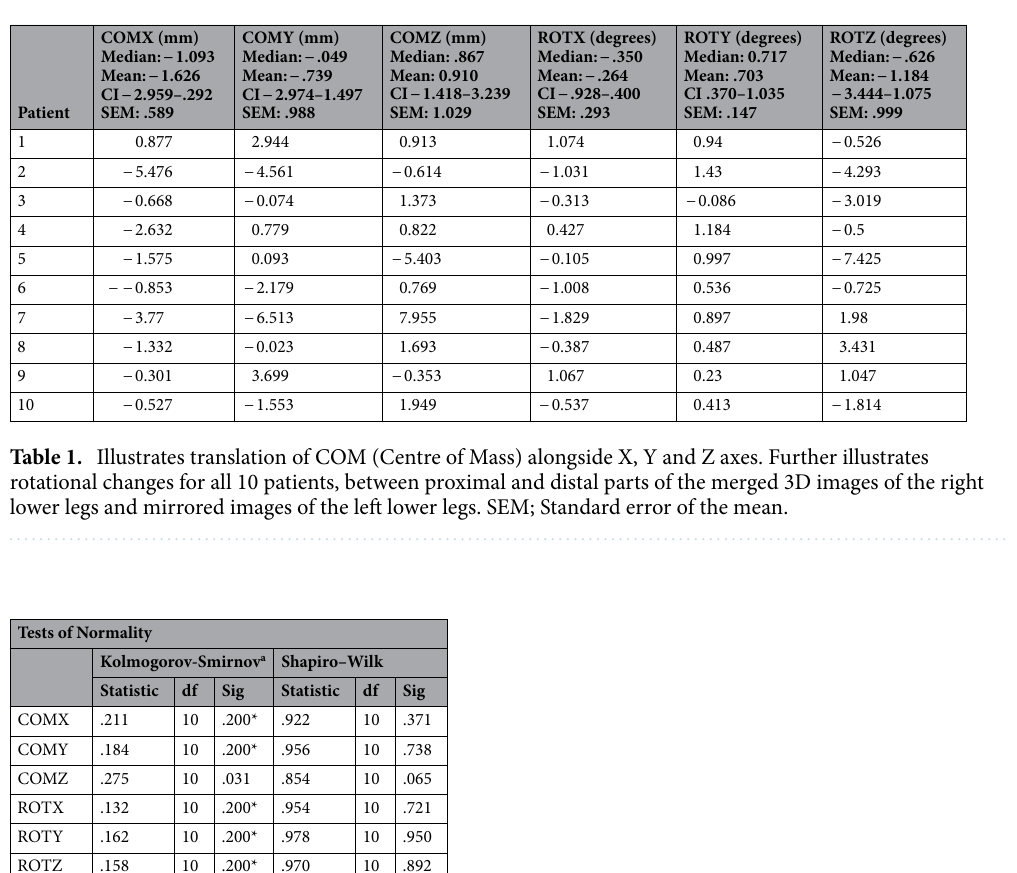
Figure 3. Illustrates automatic calculation of translation of Centre of Mass (COM) and Rotational differences around X, Y and Z axes.